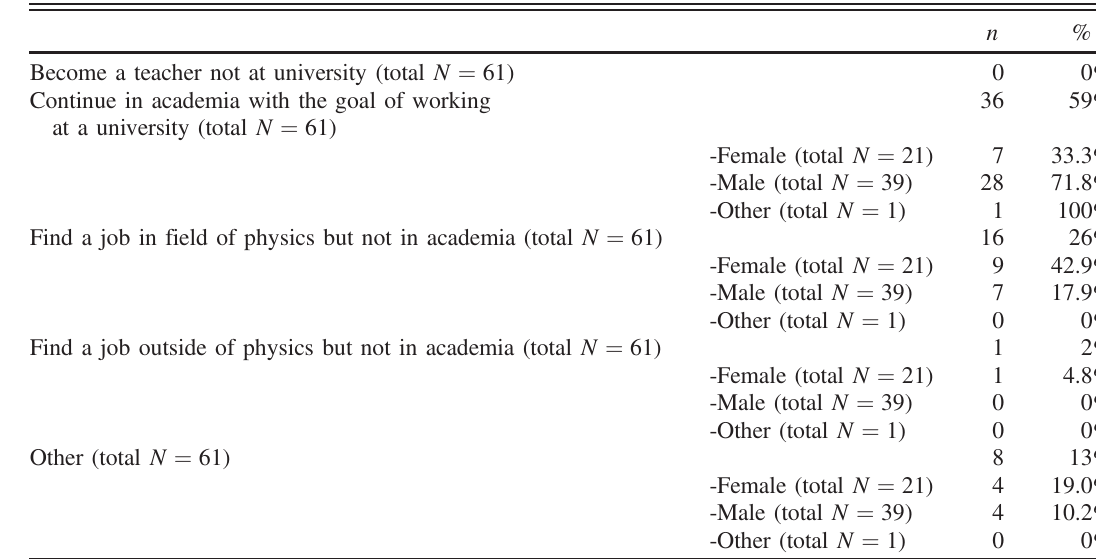
TABLE IV. Ph.D. career